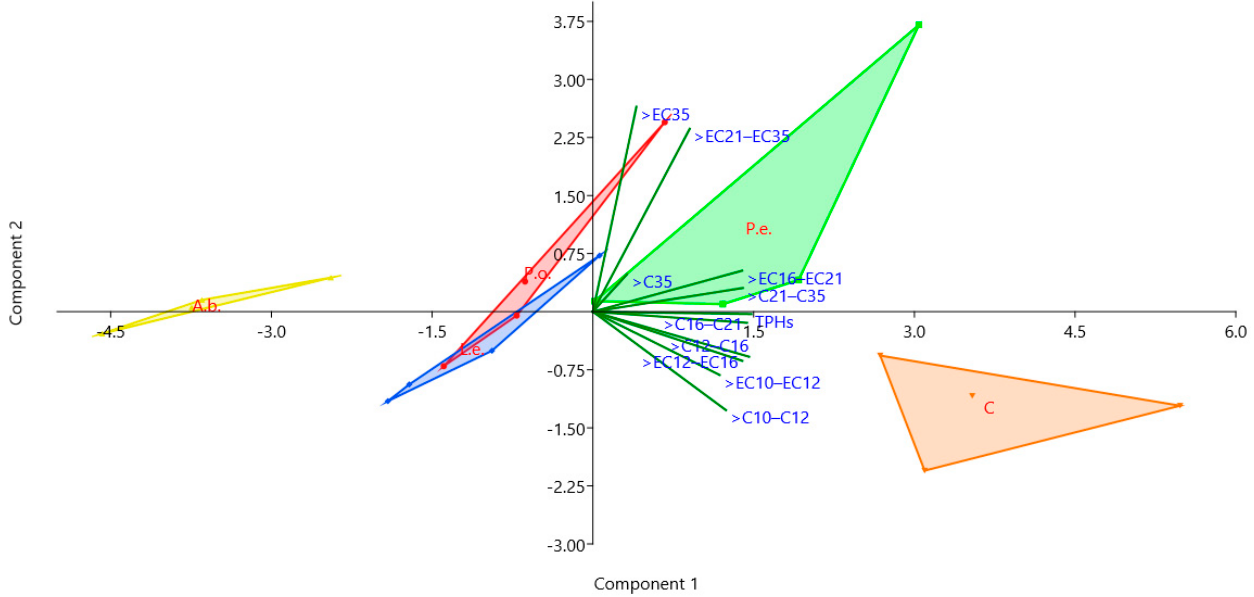
Figure 2. Principal component analysis of the control microcosms (C) and the bioaugmented micro- cosms with SMS of P. eryngii (P.e.), L. edodes (L.e.), P. ostreatus (P.o.), and A. bisporus (A.b.) showing loading scores of the residual concentration of TPHs and their aliphatic (C 10 –C 12 , C 12 –C 16 , C 16 –C 21 , C 21 –C 35 and >C 35 ) and aromatic (EC 10 –EC 12 , EC 12 –EC 16 , EC 16 –EC 21, EC 21 –EC 35 and >EC 35 ) fractions.